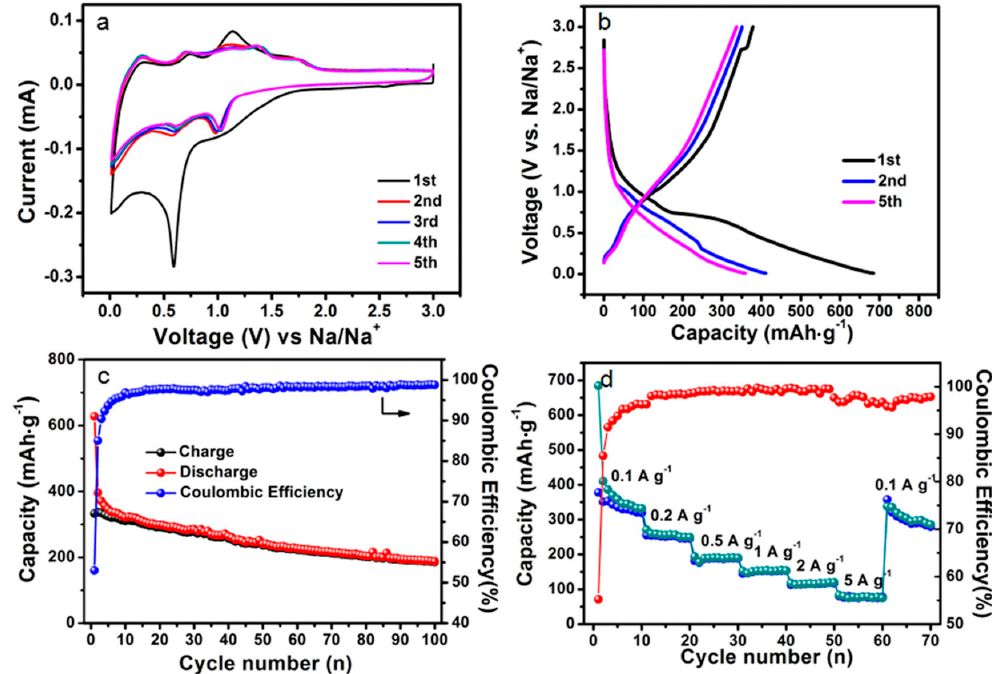
Figure 6. ( a ) CV curves; ( b ) discharge/charge profiles; ( c ) cycling performance at 0.1 A·g − 1 for 100 cycles and ( d ) rate performances at different current densities of the SnS@C composites for SIBs.